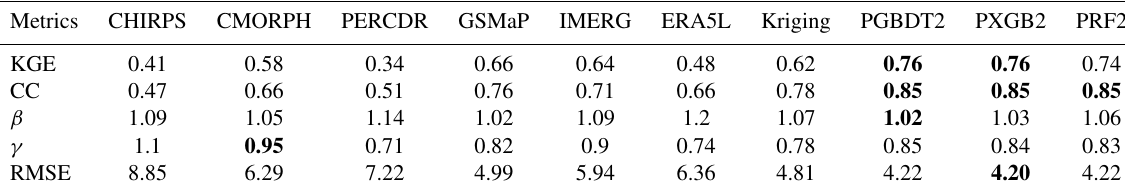
Table 4. The average values of statistic metrics of multiple products compared with gauge observations during the whole period (the unit of RMSE is mmd − 1